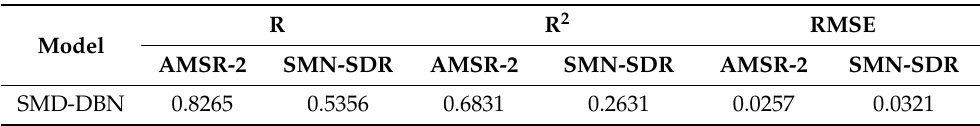
Table 8. Comparison of the SMD-DBN downscaling result with original AMSR-2 SM and in situ measurement data.